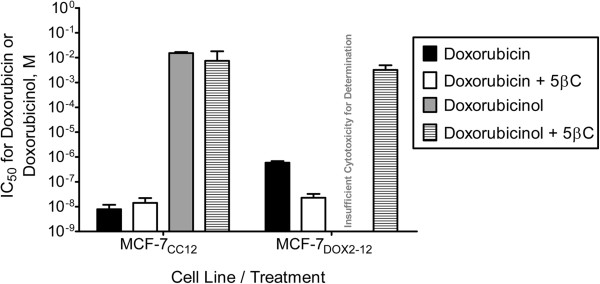
Doxorubicin and doxorubicinol cytotoxicity in MCF-7CC12and MCF-7DOX2-12cells upon treatment with or without 5β-cholanic acid. MCF-7CC12 and MCF-7DOX2-12 cells were assessed for their sensitivity to doxorubicin and doxorubicinol in the presence or absence of the AKR1B10, AKR1C2, and AKR1C3 inhibitor 5β-cholanic acid using a clonogenic assay.